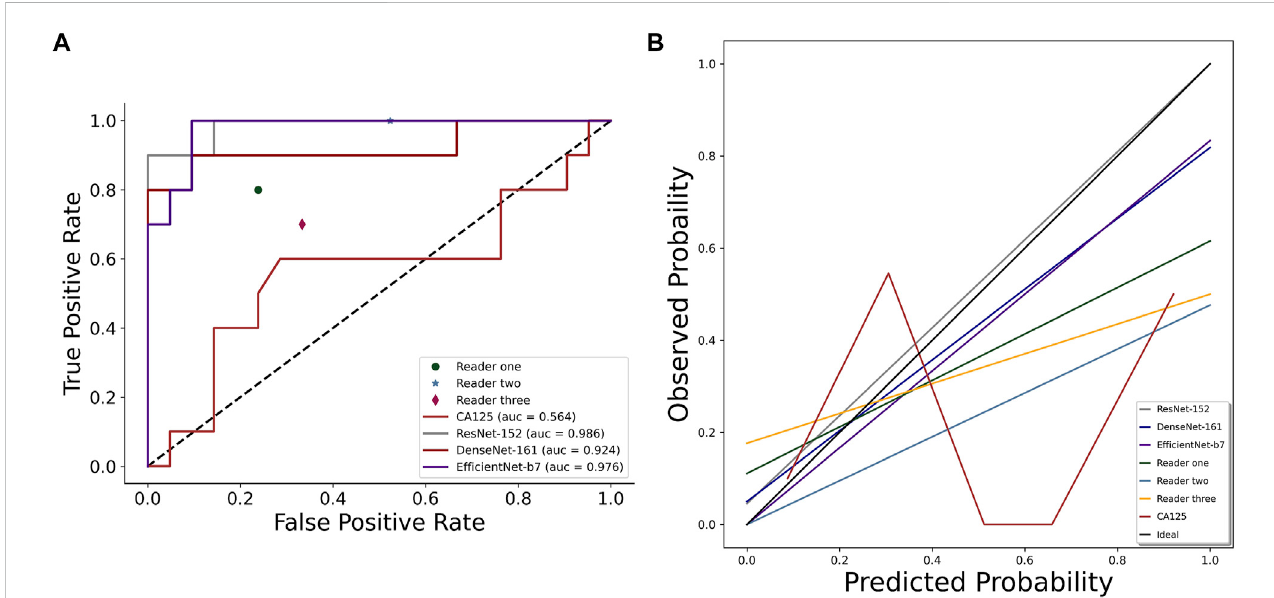
FIGURE 3 Comparison of AUROCs (A) and calibration curve (B) among CNN models (ResNet-152, DenseNet-161, and Ef fi cientNet-B7), sonographer 1, sonographer 2, sonographer 3, and CA125 on the independent test set.